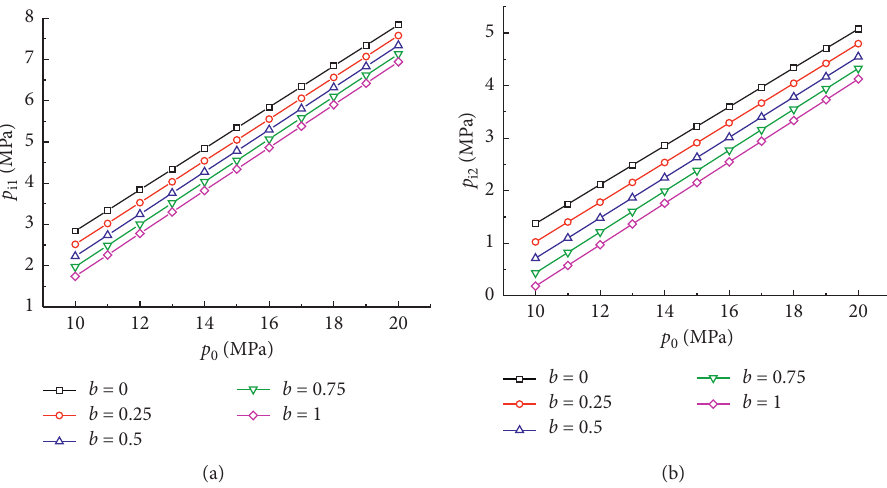
Figure 5: Influence of initial field stress on thecritical support pressure under different intermediate principal stress coefficients. (a) p